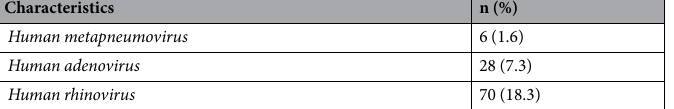
(Table S1). Co-detection with viruses known to be frequent causes of acute respiratory infection were observed: Human rhinovirus in 12 (7.6%), Human adenovirus in 6 (3.8%), Human parainfluenza virus in 3 (1.9%), Influenzavirus in 1 (0.6%). Human metapneumovirus was not detected in any RSV-positive patients. The main bacterial species co-detected with RSV were S. pneumoniae and H. influenzae in 98 (62.4%) and 84 (53.5%), respectively.